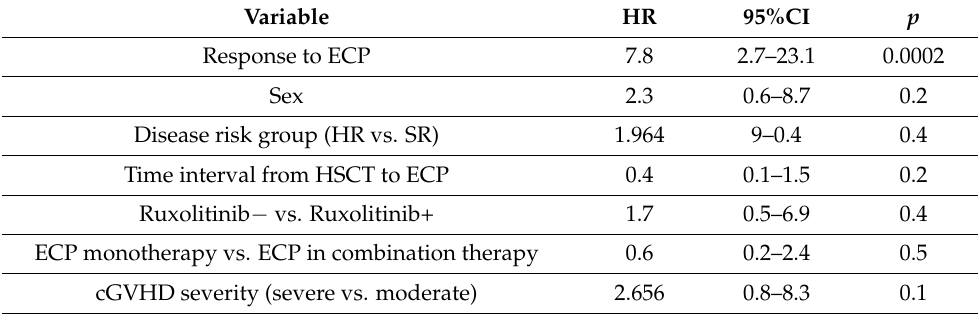
Table 3. An univariate analysis of factors influencing